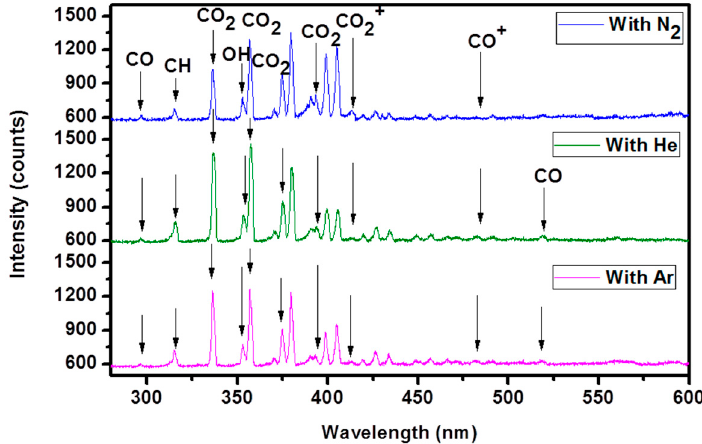
Figure 9. Emission spectra of CO 2 decomposition reaction (Flow rate 30 mL/min, Glass beads packed DBD, Applied voltage 22 kV, Plasma frequency 50 Hz, Grating: 600 glue at 500 nm).